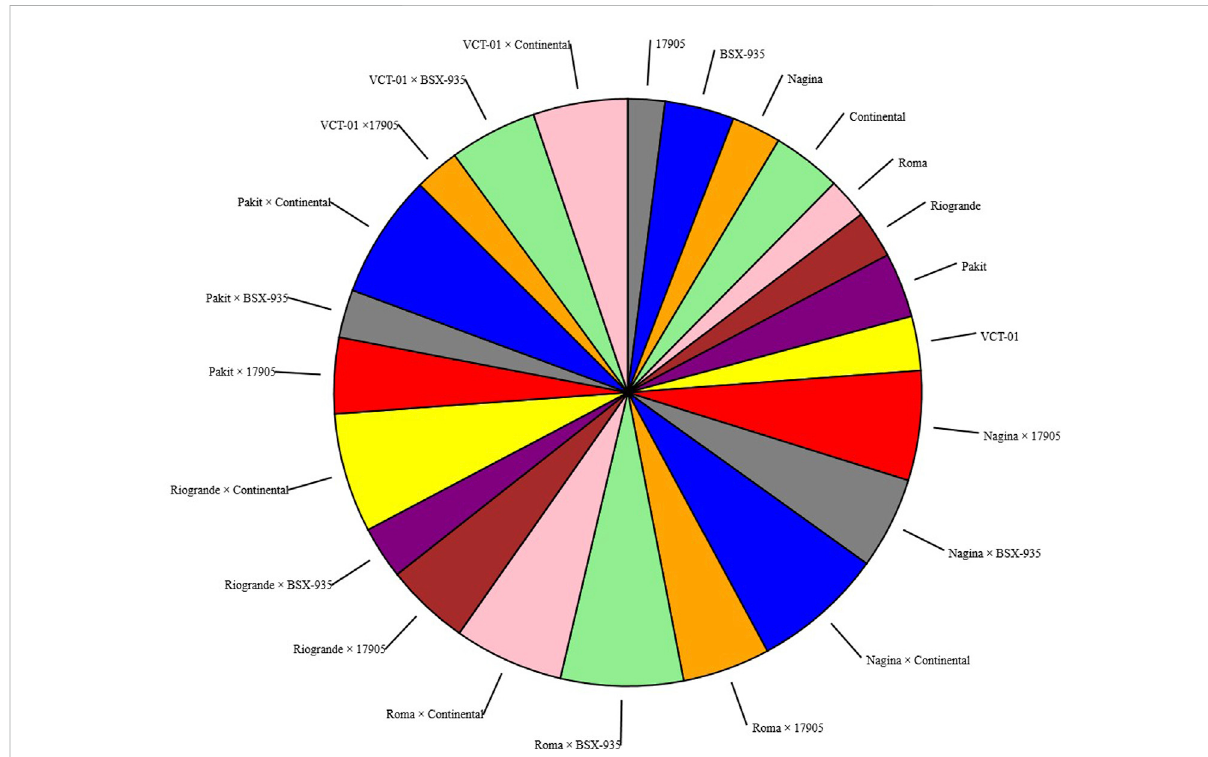
FIGURE 2 Pie chart shows the different values of a given variable. Pie chart represents the size of the value of YP (kg) for each parent and hybrid.